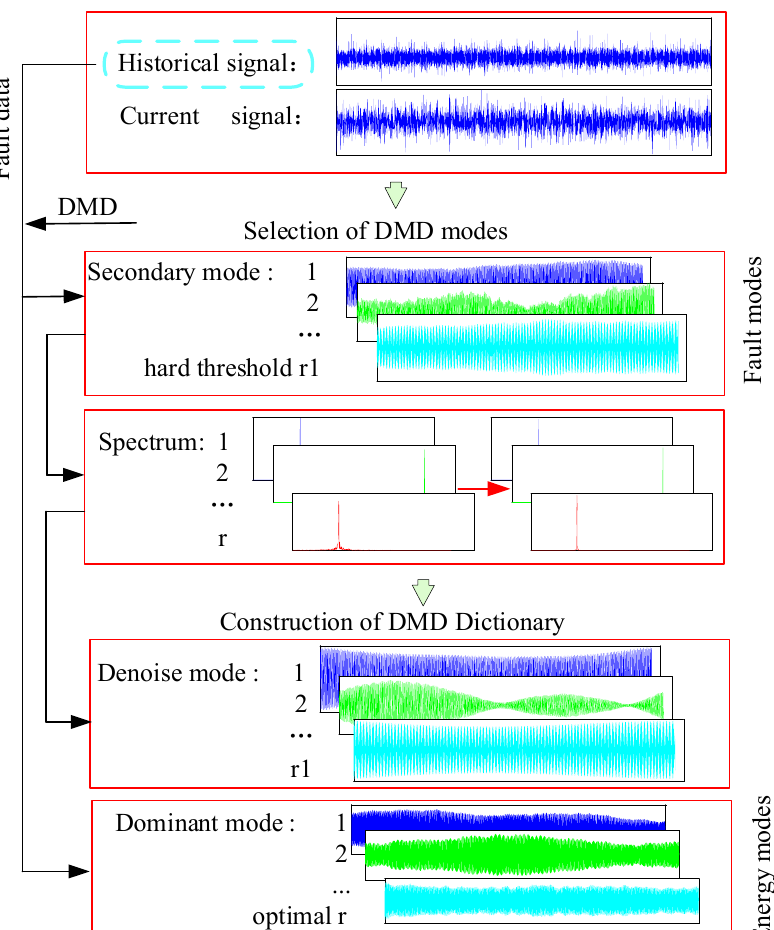
Figure 3. Flow chart of the dictionary construction process.